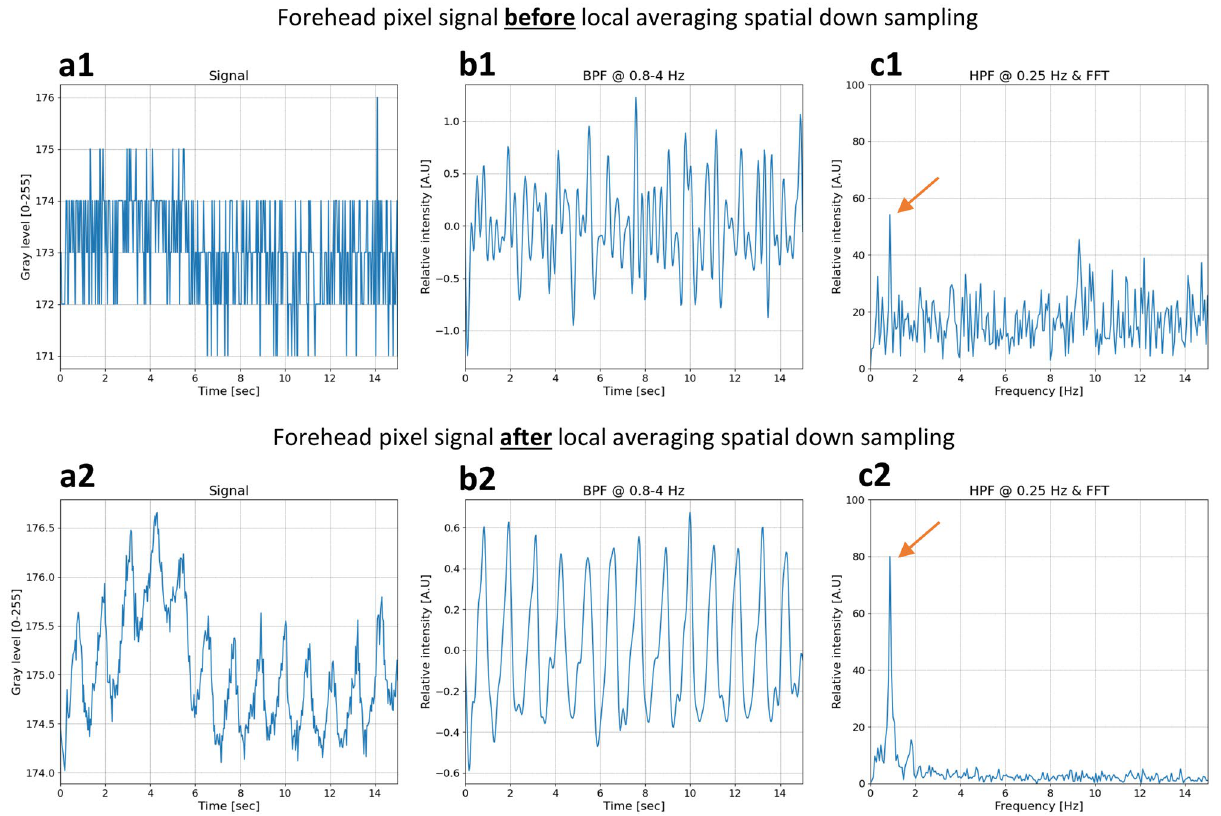
Figure 9. A forehead pixel temporal signal before ( a1 – c1 ) and after ( a2 – c2 ) the two-stages spatial downsampling by local averaging. ( a1, a2 ) The temporal signal. ( b1, b2 ) The temporal signal after band-pass filtering at frequency band 0.8–4 Hz. ( c1, c2 ) The signal at the frequency domain, where the estimated heart rate (EHR) component is marked with an orange arrow.